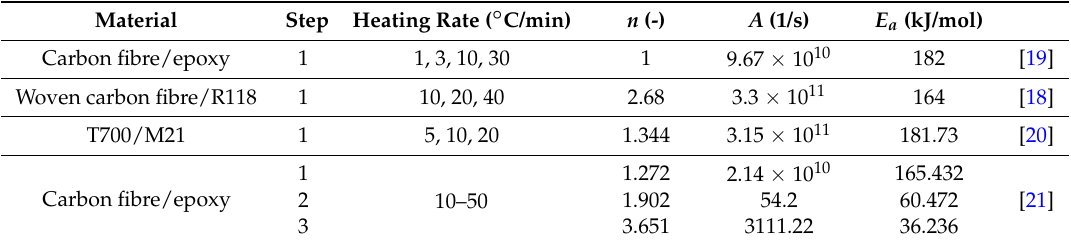
Table 1. Kinetic parameters of different carbon epoxy materials based on TG analysis under nitrogen n th order decomposition kinetic model.